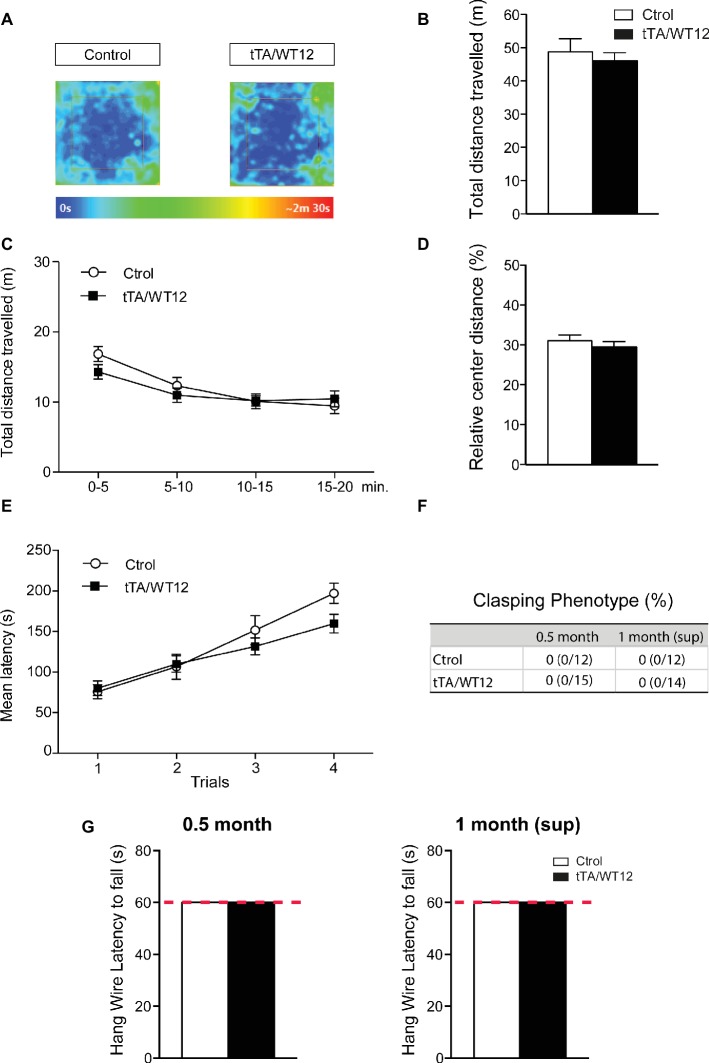
Motor domain remains unaltered after 2 weeks of suppression of hTDP-43-WT transgene. (A–D) Open-field task; locomotor and exploratory behaviors were preserved in suppressed hTDP-43-WT mice. (A) Occupancy plot. Representative heat maps for time spent by subject mice during the entire session are shown. The heat map was constructed based on body position. (B) Total distance traveled. (C) Total distance traveled in time segments of 5 min. (D) Relative center distance. No significant differences were found between controls and bigenic animals in locomotion or exploration. (E) Motor coordination and balance were not affected after suppression of hTDP-43-WT expression. Accelerated rotarod performance (4–40 rpm/5 min): four trials per test were performed during the test day with a 2-min interval between trials. Latency to fall off the apparatus was recorded. (F–G) No signs of spasticity or motor strength deficits are detected in suppressed hTDP-43-WT mice. (F) The absence of clasping phenotype in both 0.5 month and 1 month (sup) mice. Percentage of animals positive for abnormal clasping and number of animals positive/total tested are shown. (G) Hanging wire grip test. Grip strength was assessed using a standard wire cage turned upside down. The latency to fall off the wire lid was quantified; a 60-s cutoff time was used. No significant differences were found between control and bigenic animals [p > 0.05 Student’s t test in (B,D), Mann-Whitney U test in (G), repeated-measures ANOVA in (C,E), Fisher’s exact test in (F)]. n = 12, 15 for control and bigenic 0.5 month mice, respectively; n = 12, 14 for control and bigenic 1 month (sup) mice, respectively. Data represent mean ± SEM.